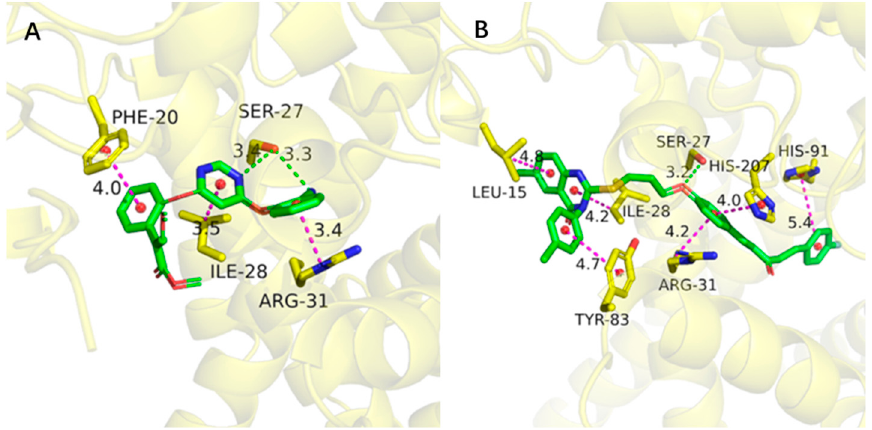
Figure 10. Binding models of the compounds azoxystrobin ( A ) and W12 ( B ) with SDH protein (PDB ID: 2WDQ). The purple line indicates hydrophobic interactions between compounds and surrounding residues. The green line indicates hydrophilic hydrogen bond interactions.